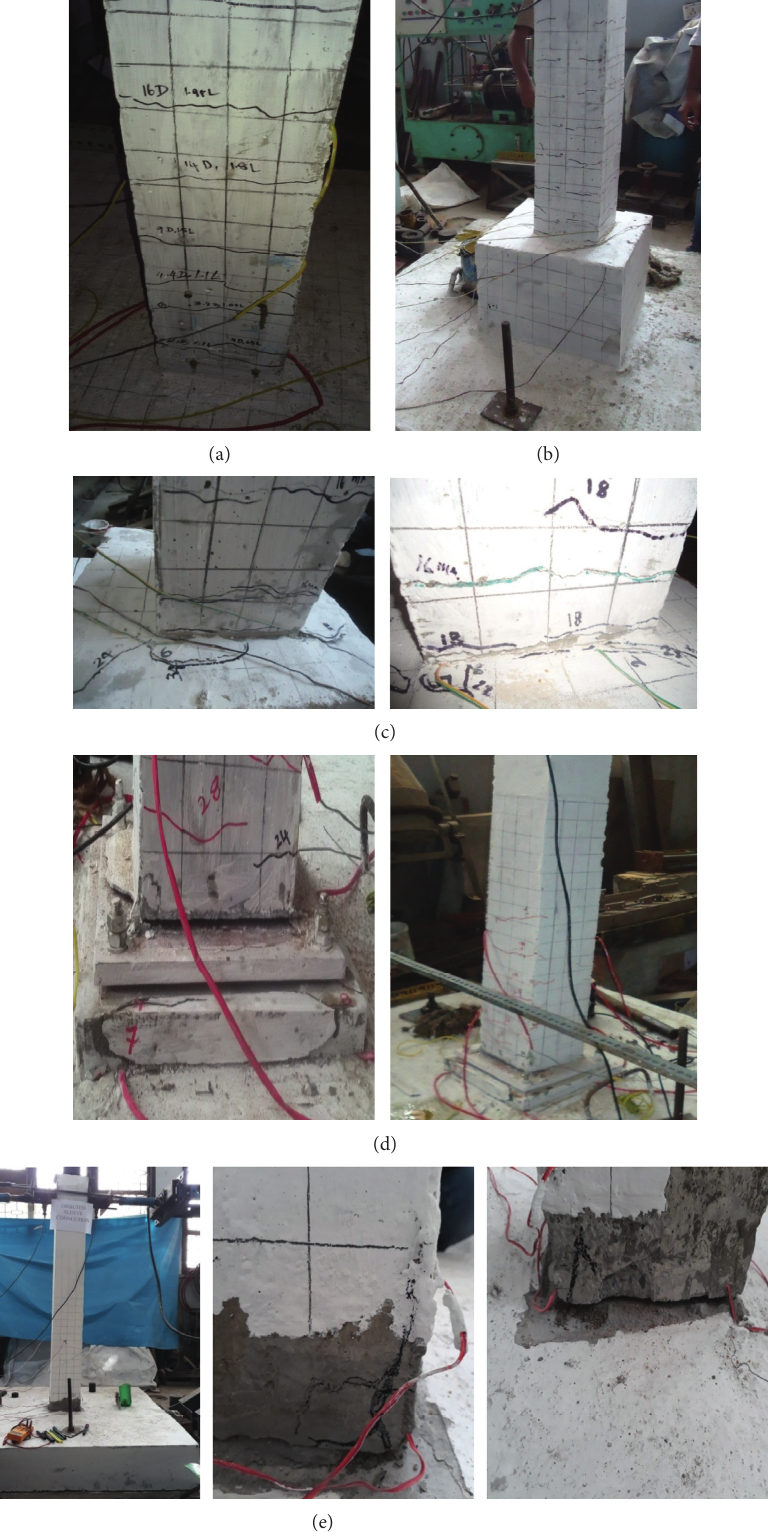
Figure 14: (a) Crack pattern on monolithic column, (b) crack pattern on PC I, (c) crack pattern on transverse of PC I and PC II, (d) development of visible cracks and damage of grout in precast specimen PCBJ, and (e) visible cracks in grouted sleeve